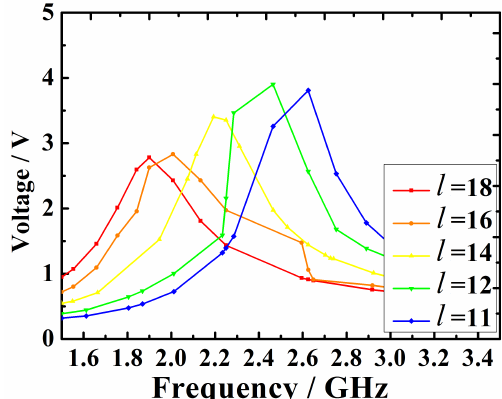
Figure 3. Induced voltage at both ends of the diode with 1 watt incidence power.